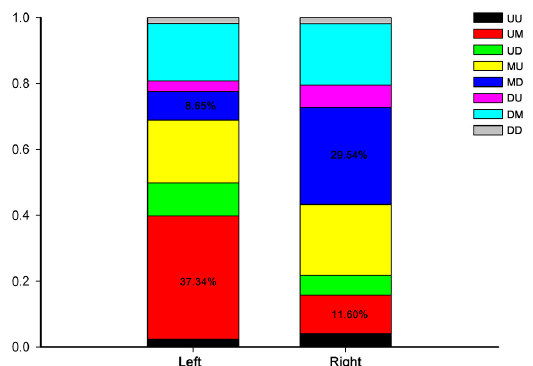
Figure 8. The percentage of genes within each expression pattern in the left and right gonads. The eight possible patterns included up-up (UU), up-maintain (UM), up-down (UD), maintain-up (MU), maintain-down (MD), down-up (DU), down-maintain (DM), and down-down (DD).